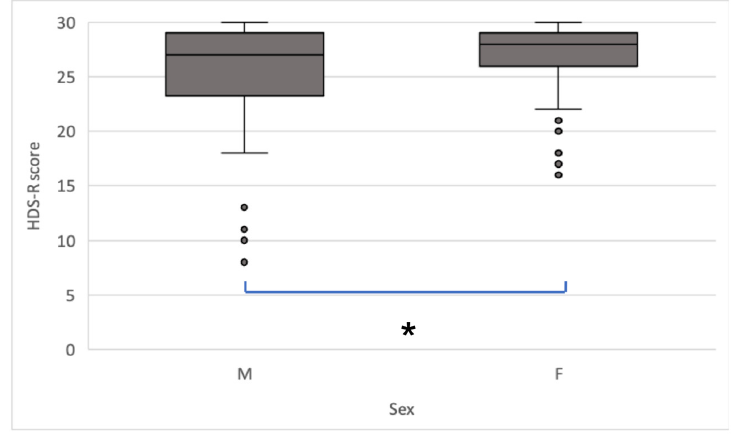
Figure 1. HDS-R scores by sex. Scores were significantly higher in women than in men (* p = 0.037, two-sided Mann–Whitney U test). The center line shows the mean, boxes show the IQR, and whiskers indicate the range. Dots indicate outliers.